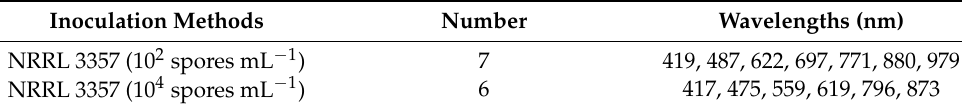
Table 4. Key wavelengths selected by